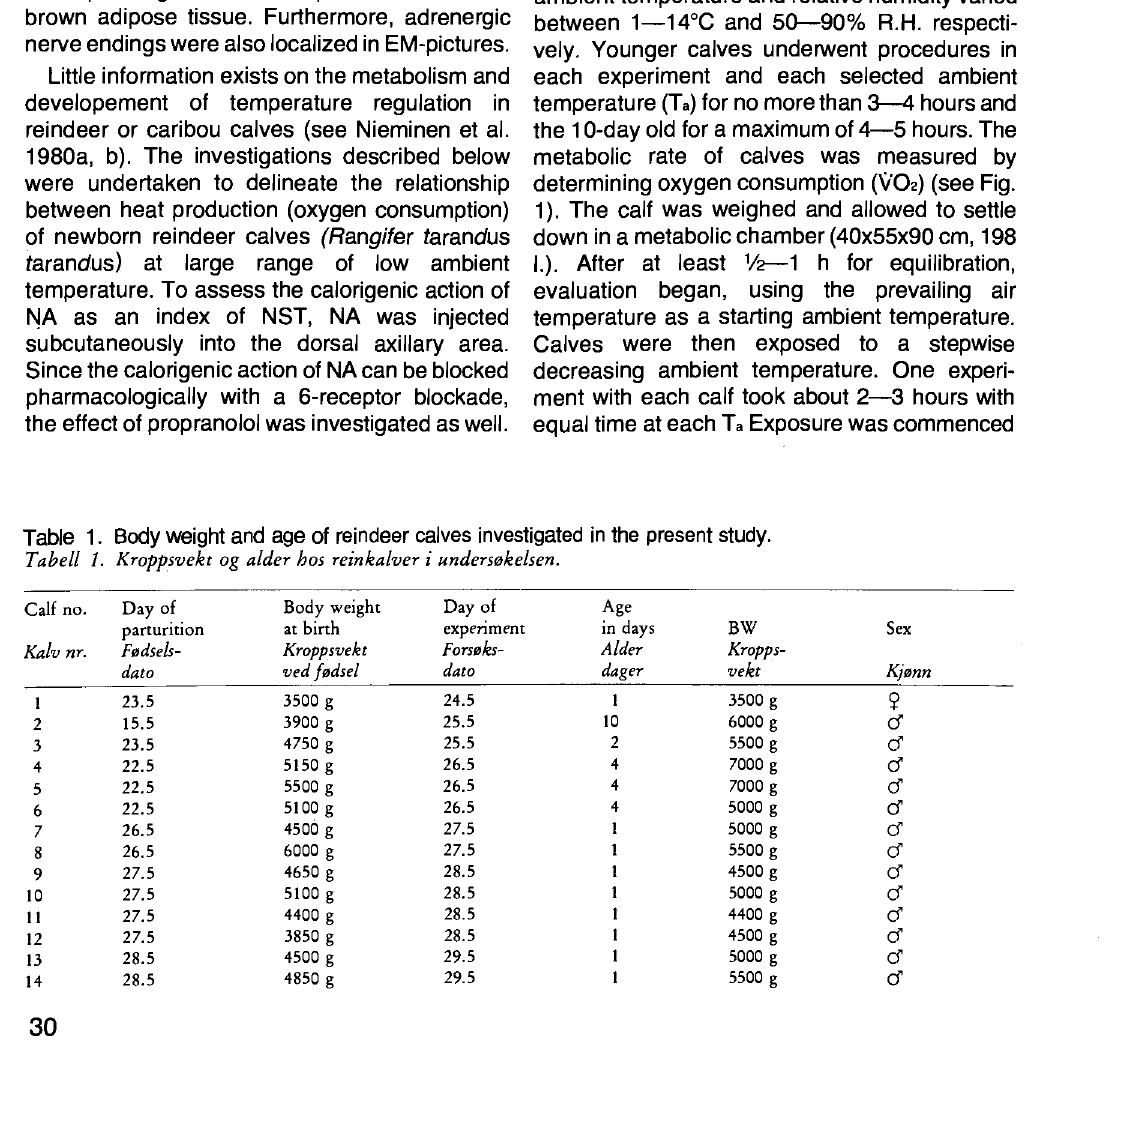
Table 1 . Body weight and age of reindeer calves investigated in the present study. Tabell 1. Kroppsvekt og alder hos reinkalver i undersøkelsen. Calf no. Day